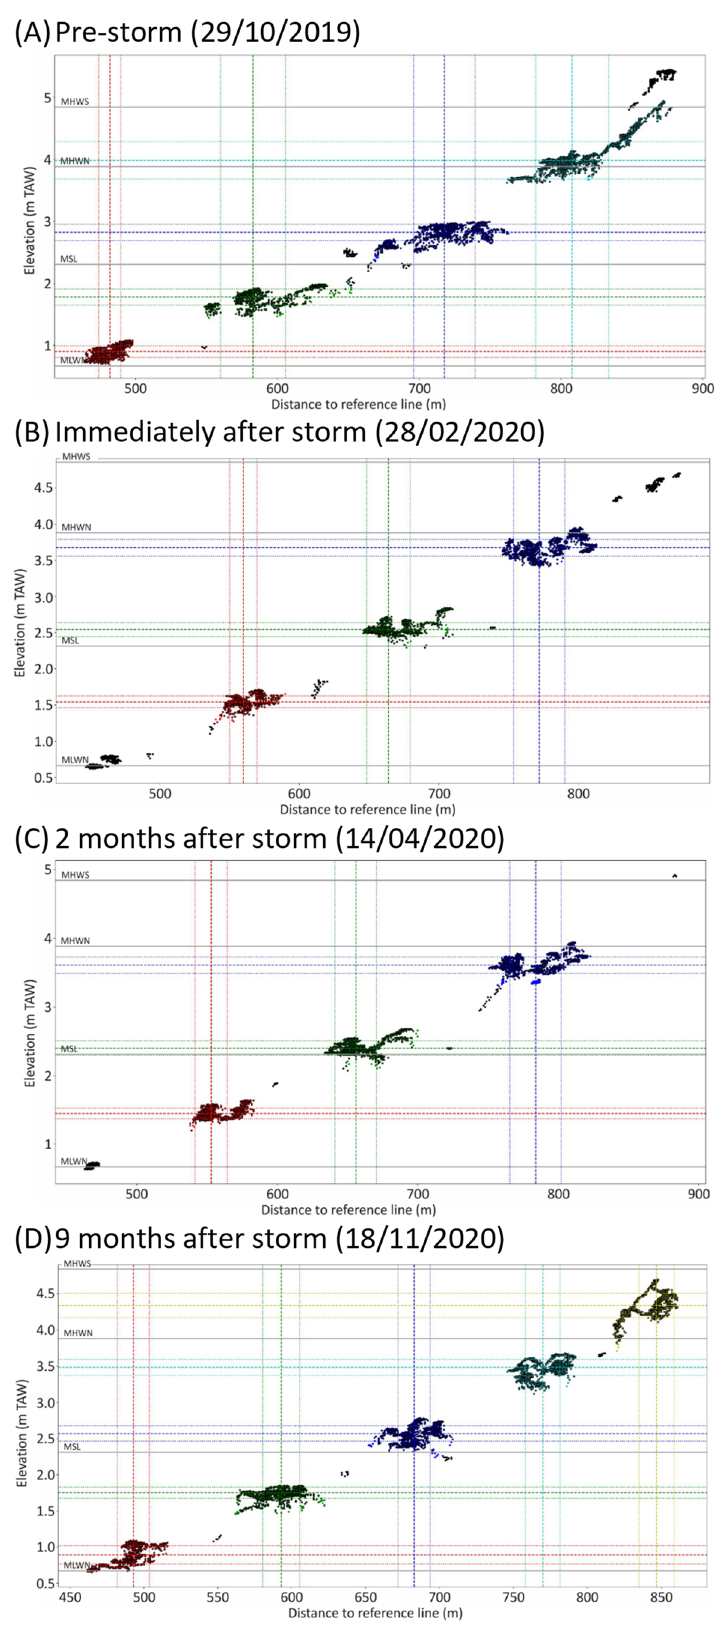
Figure 6. Cluster plots over all cross-profiles of bar elevation on ( A ) 29 October 2019 (pre-storm), ( B ) 28 February 2020 (immediately after storm), and ( C ) 14 April 2020 (2 months after) and ( D ) 18 November 2020 (9 months after). Note: The axes are different due to the slight size difference of the